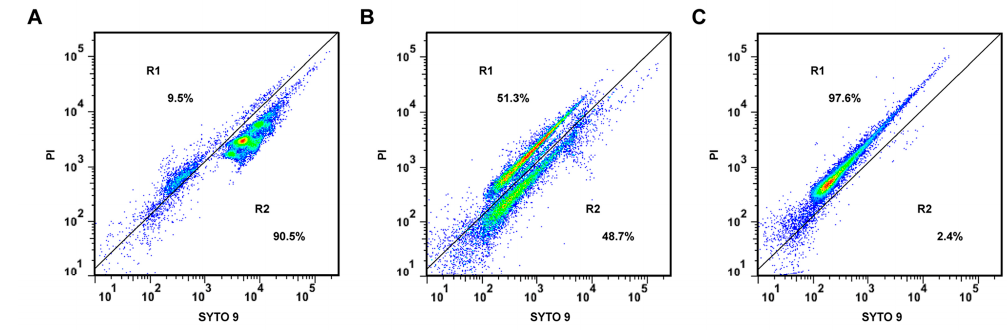
Figure 3. Flow cytometric analysis of SYTO 9-PI (propidium iodide)-stained S. aureus ATCC 6538. ( A ) untreated; ( B ) treated with CHQA at 2 × MIC for 3 h; ( C ) treated with 70% isopropyl alcohol for 3 h. Regions R1 and R2 represent the membrane damaged or dead cells and live cells, respectively.